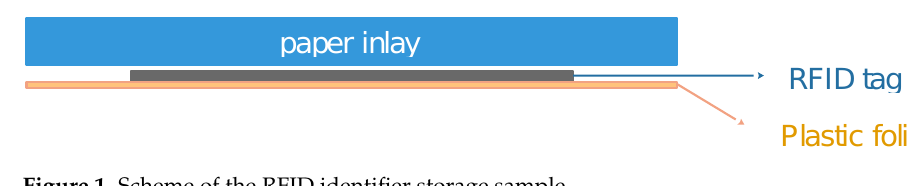
Figure 1. Scheme of the RFID identifier storage sample.